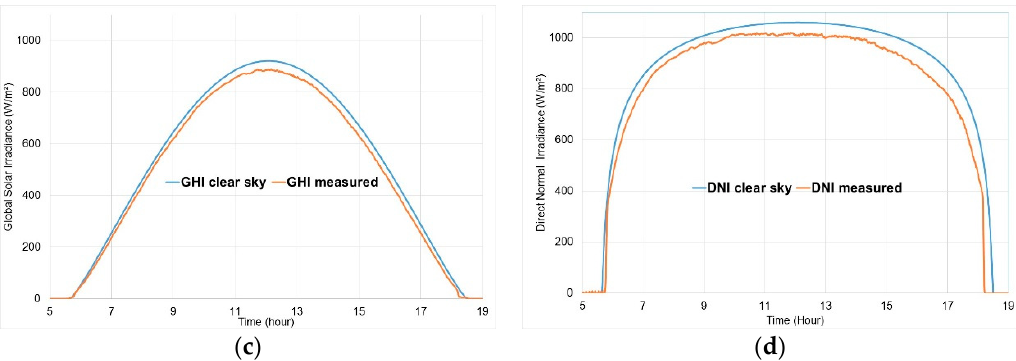
Figure 9. Experimental and modelled solar irradiance curves in clear sky conditions (hour in true solar time) (Odeillo site), ( a ) GHI, April; ( b ) DNI, April; ( c ) GHI, September; ( d ) DNI, September.